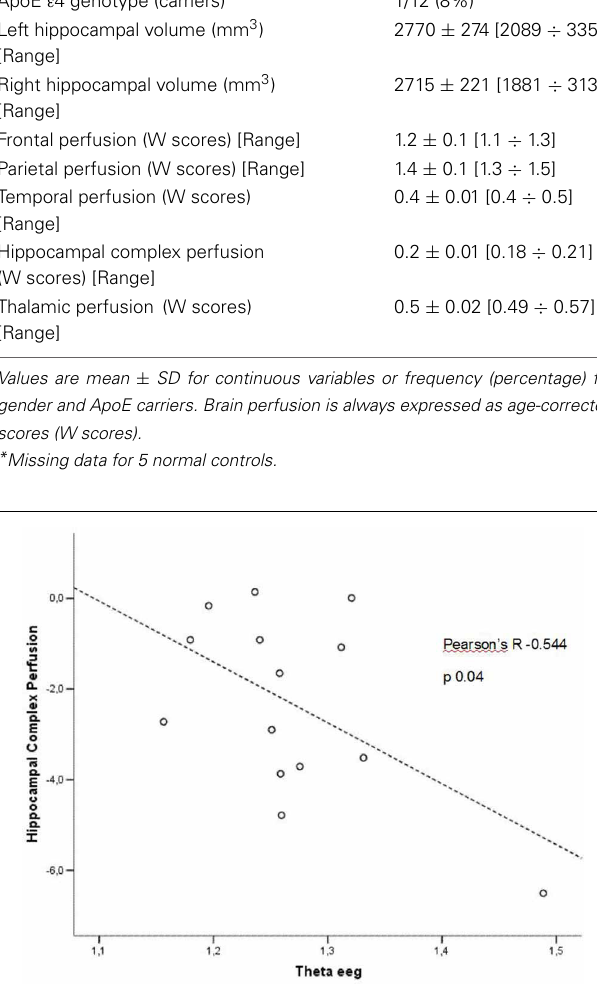
conditions can disturb the normal electrical field of the brain.